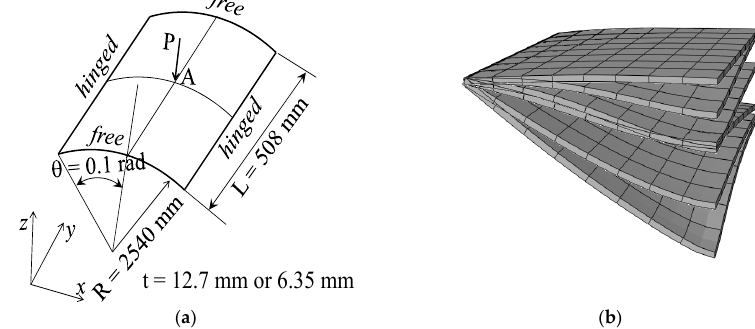
Figure 11. Hinged cylindrical roof: ( a ) geometry and ( b ) undeformed and deformed configurations.